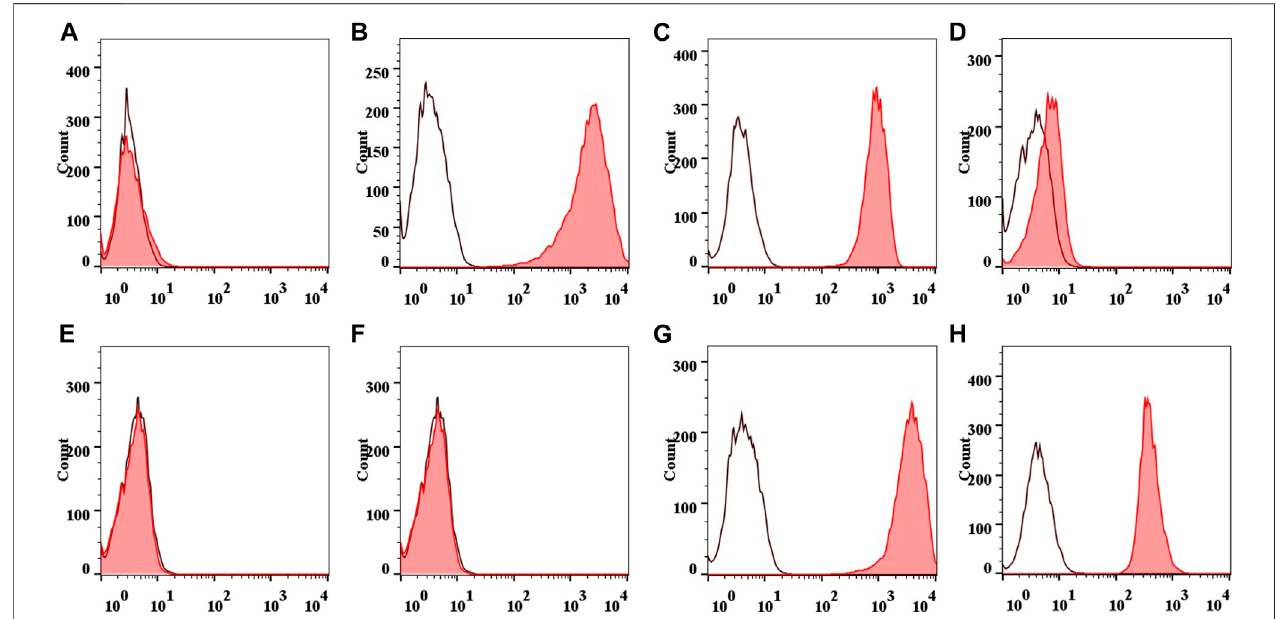
FIGURE 4 | Flow diagram of IPFP-SCs surface markers. Collagenase free: CD44 (A) , CD90 (B) , CD45 (C) , and CD34 (D) . Collagenase treated: CD44 (E) , CD90 (F) , CD45 (G) , and CD34 (H) .